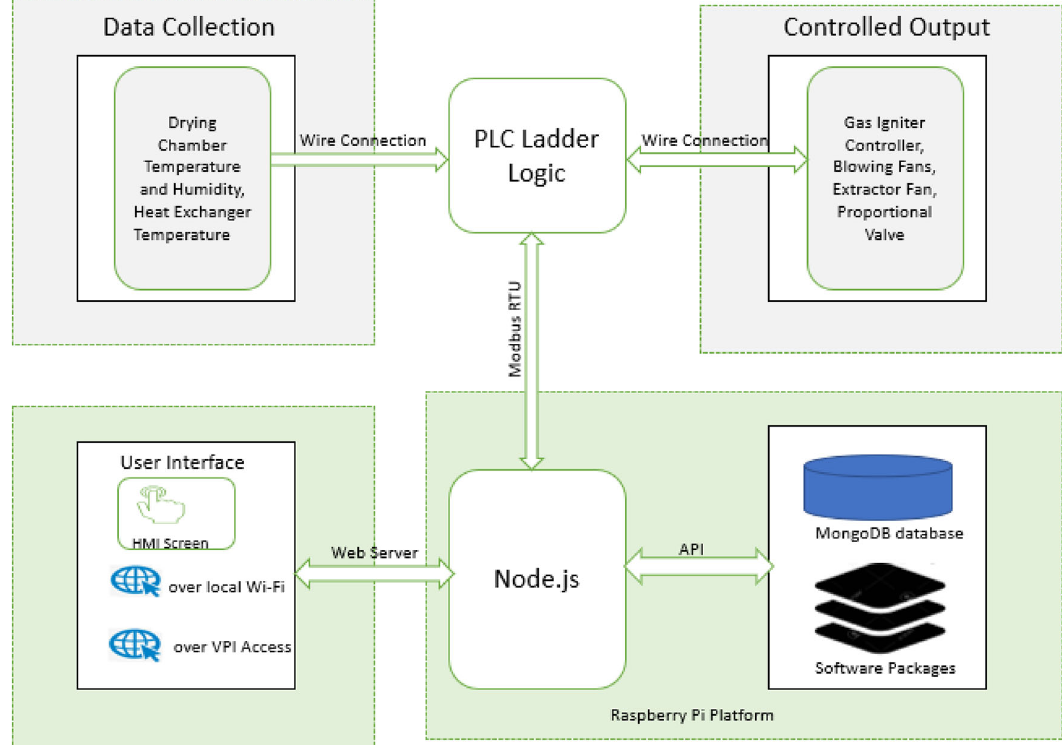
Figure 8. System software